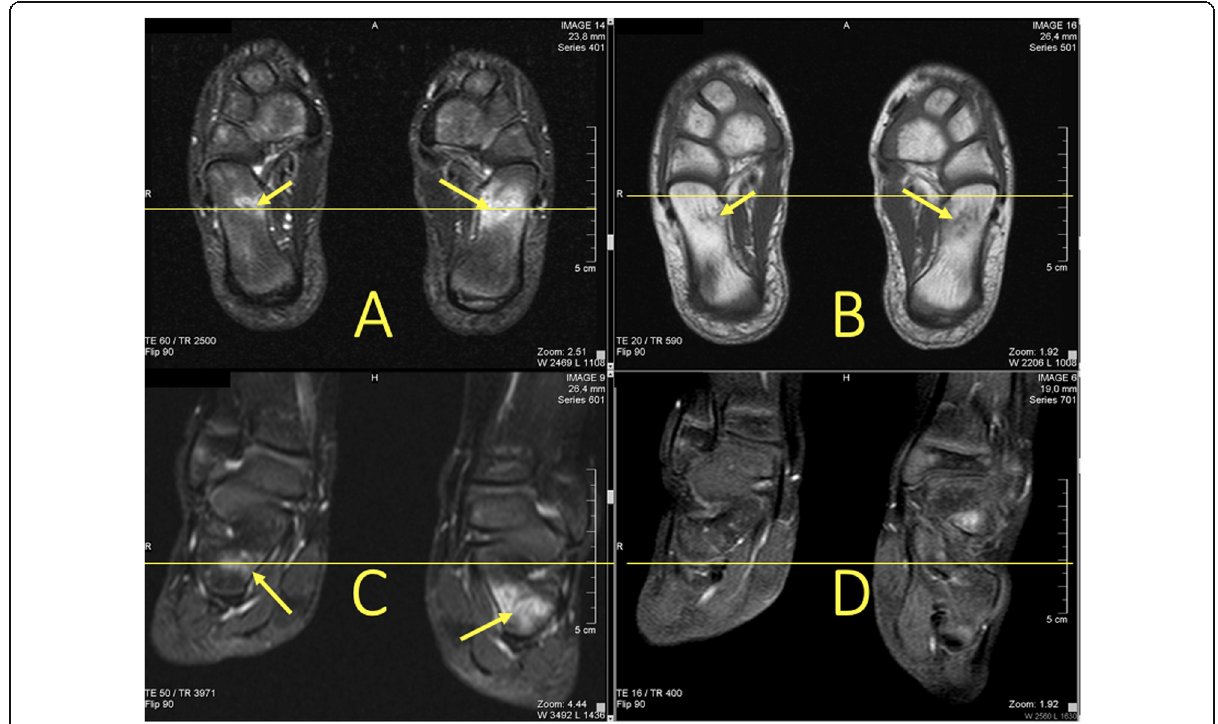
Fig. 33 A 7-year-old girl with chronic pain in both feet. MRI shows a developmental variation in the bone marrow signal in the calcaneus (arrows)